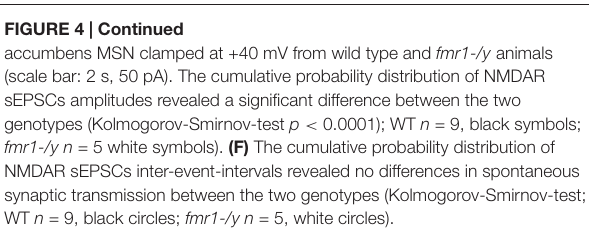
FIGURE 4 | Continued accumbens MSN clamped at +40 mV from wild type and fmr1-/y animals (scale bar: 2 s, 50 pA). The cumulative probability distribution of NMDAR sEPSCs amplitudes revealed a significant difference between the